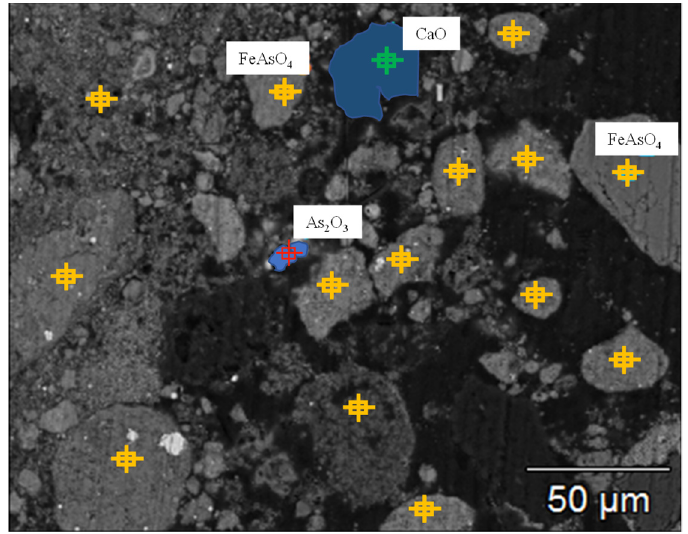
Figure 2. Mineral phase distribution of the arsenic–iron precipitate analyzed by EPMA.